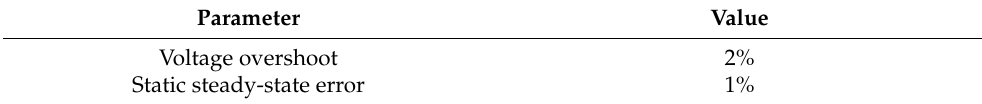
Table 5. Control performance